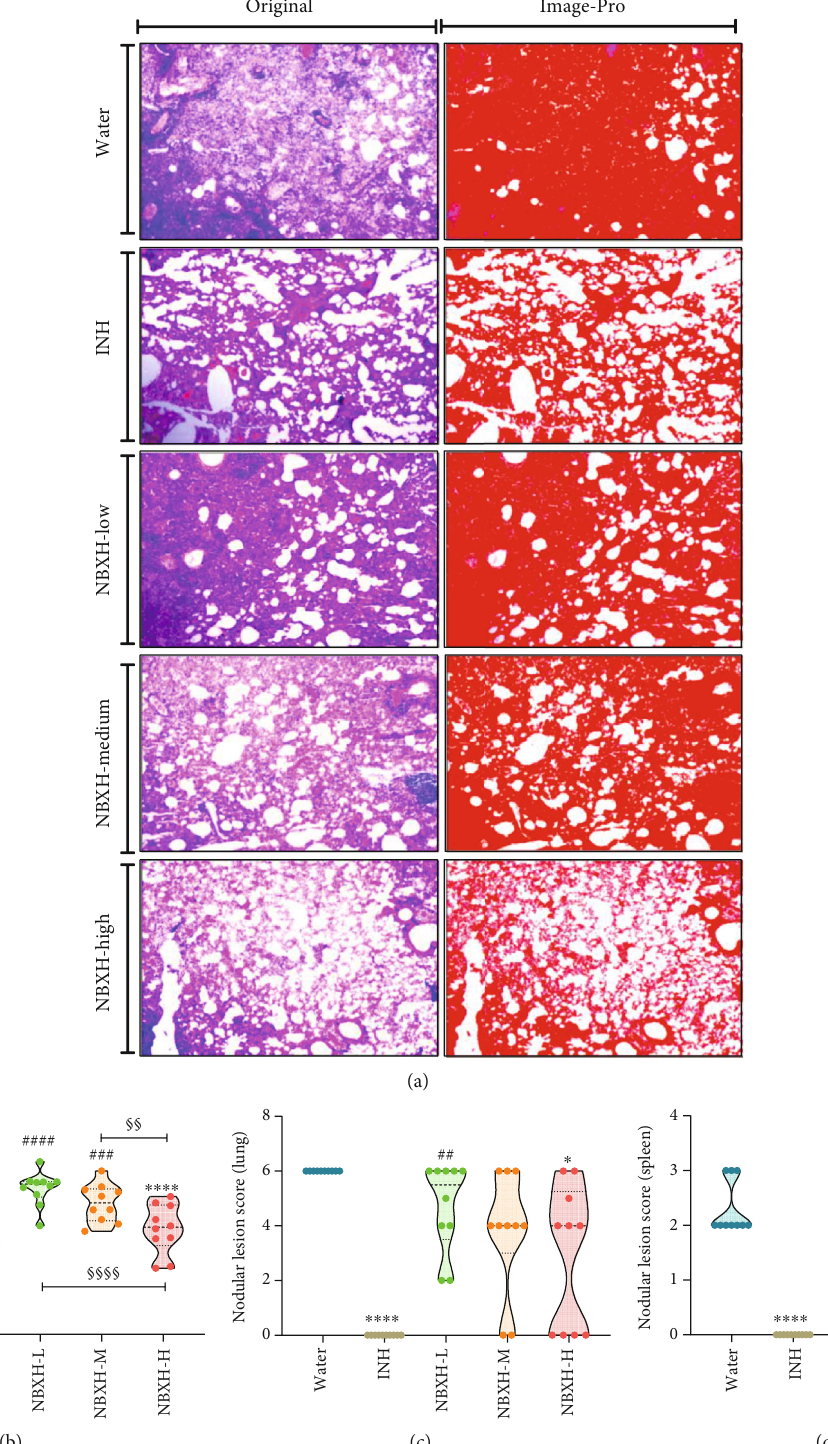
Figure 3: Pathological characteristics of mice treated with NBXH extracts. The right lobe of the lung obtained from the mouse in each group was used to perform the histopathological examination ((a) H&E stain, left lane). The lesion area of the lung was identi fi ed as a red color ((a) red, right lane) and analyzed using Image-Pro Plus software (b). Furthermore, the gross pathology of the lung and spleen was also determined, including the nodular lesion score in the lung (c) or spleen (d) according to the evaluation criteria in Table 2. Original magni fi cation times: 40x. All data are shown as means ± S : E : M : ( n = 10 ). Di ff erences were considered statistically signi fi cant at P < 0 : 05 . ∗ vs. Water: ∗ P < 0 : 05 ; ∗∗ P < 0 : 01 ; ∗∗∗ P < 0 : 001 ; ∗∗∗∗ P < 0 : 0001 ; # vs. INH: ## P < 0 : 01 ; ### P < 0 : 001 ; #### P < 0 : 0001 ; § vs. NBXH-H: §§ P < 0 : 01 ; §§§§ P < 0 : 0001